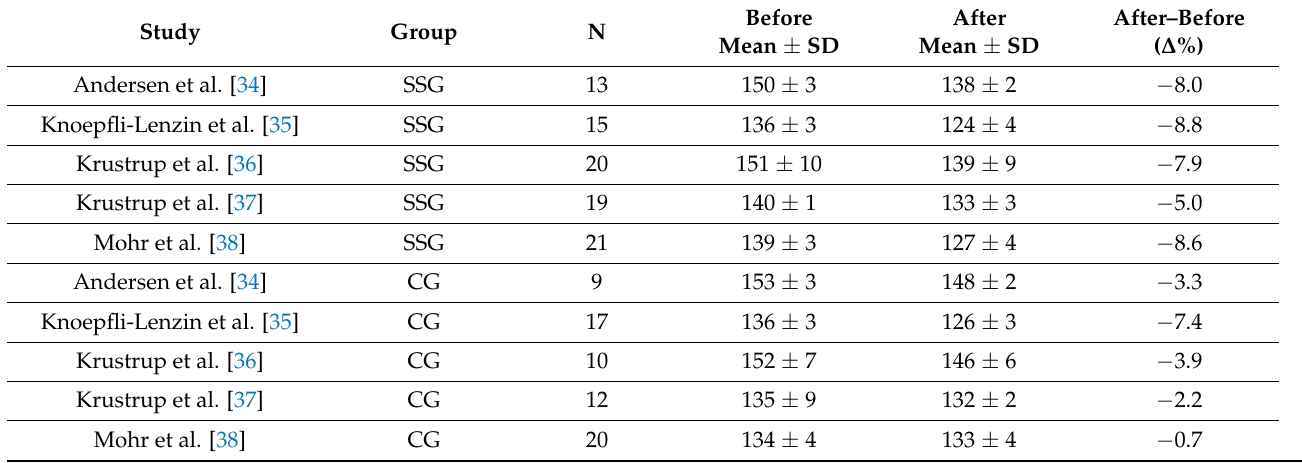
Table 5. Summary of the included studies and results of systolic blood pressure before and after intervention.